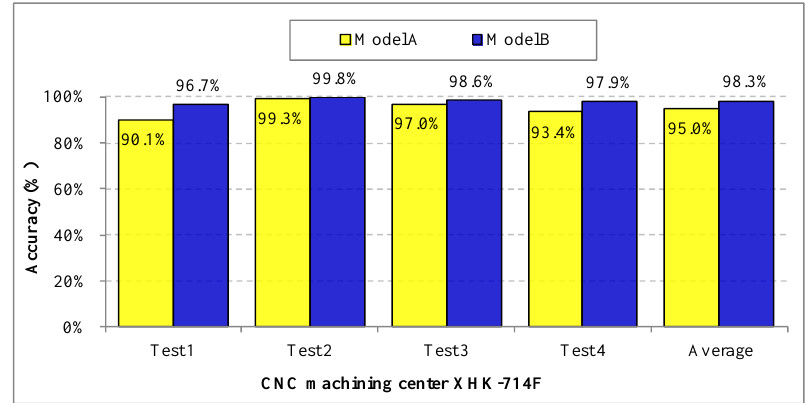
Figure 8. Comparison of accuracy of model A and B for XHK-714F CNC machining center.